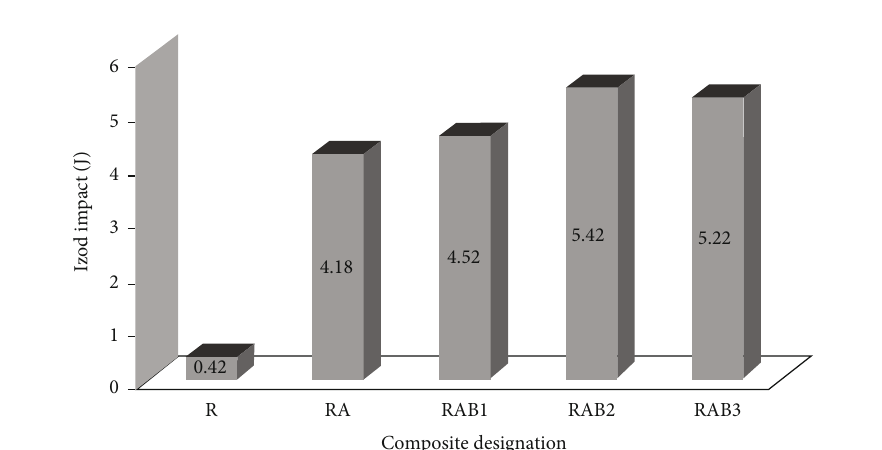
Figure 6: Flexural properties of composites.